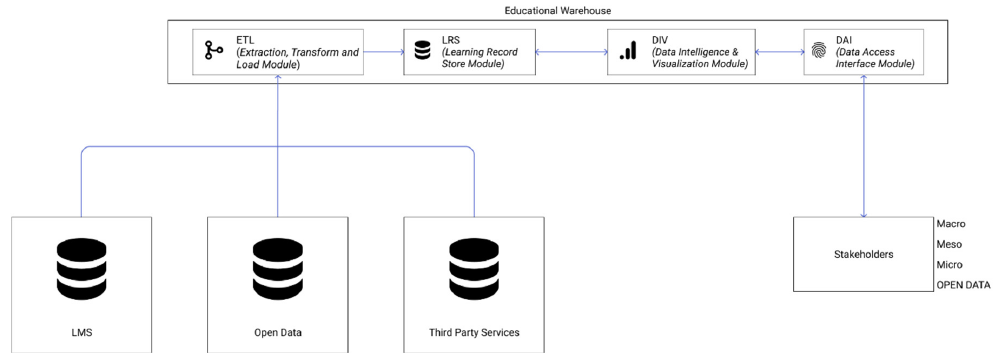
Figure 1. The educational warehouse architecture: data are exchanged from different sources to a collector module where it can be processed and then sent into record storage. When there is a petition to analyze data, the Data Intelligence and Visualization module (DIV) accesses the storage to obtain the required data and stores its results. To make the request, the stakeholders use the data access interface module.